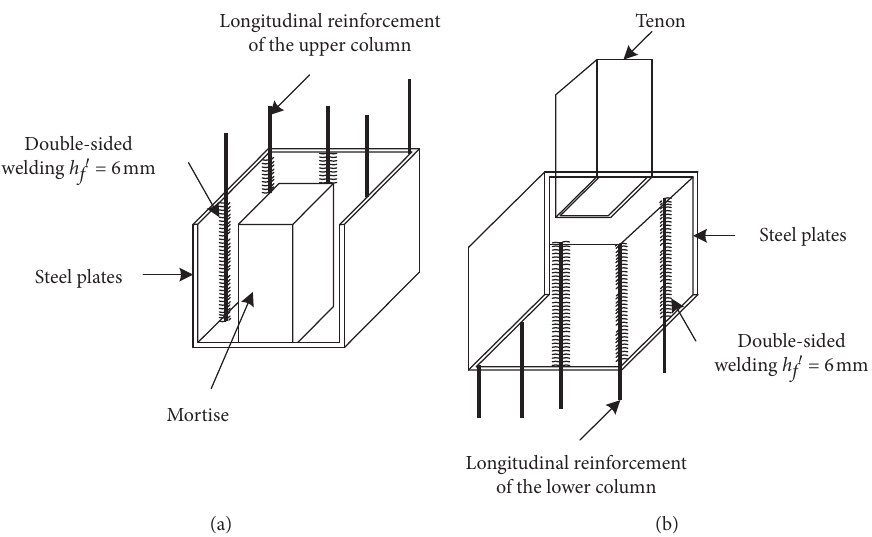
Figure 3: The welding of the steel bars on the inner face of the connector: (a) mortise; (b) tenon.